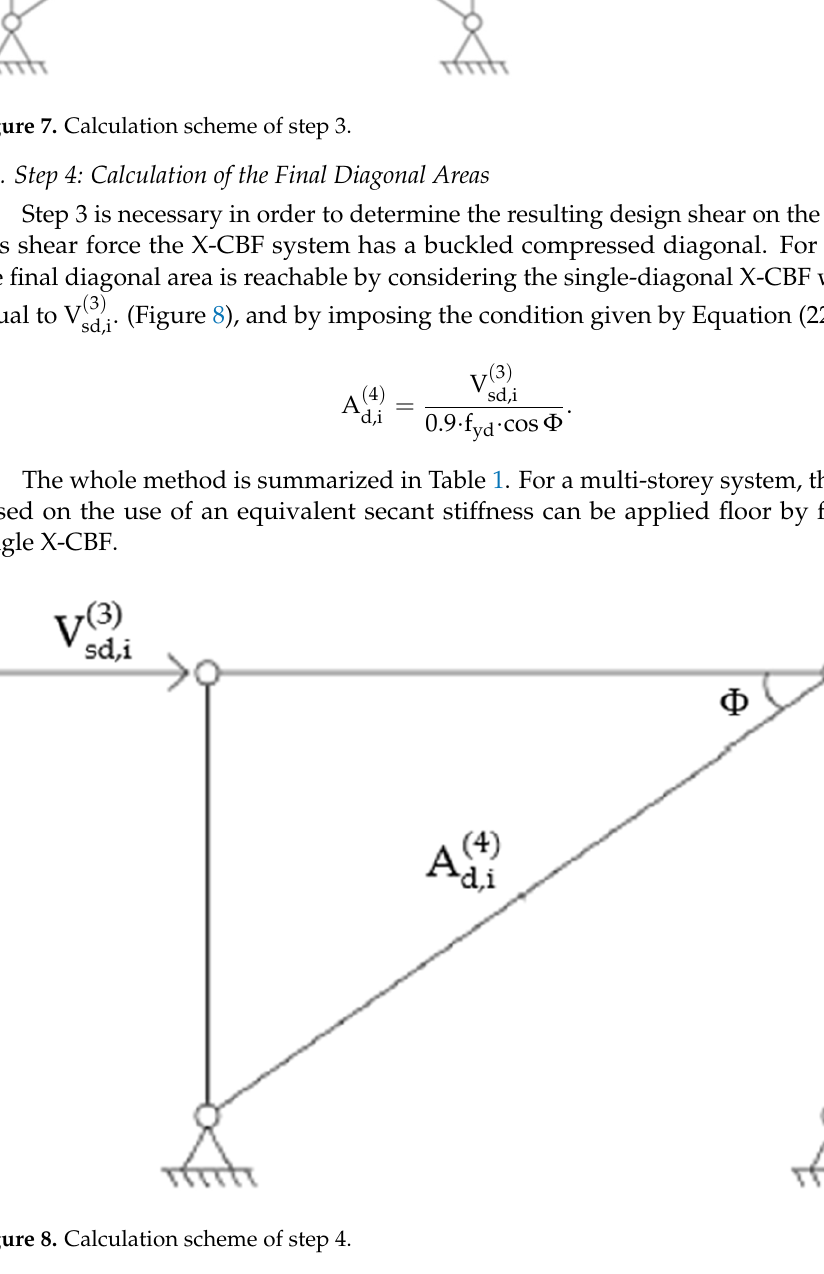
Figure 8. Calculation scheme of step 4.